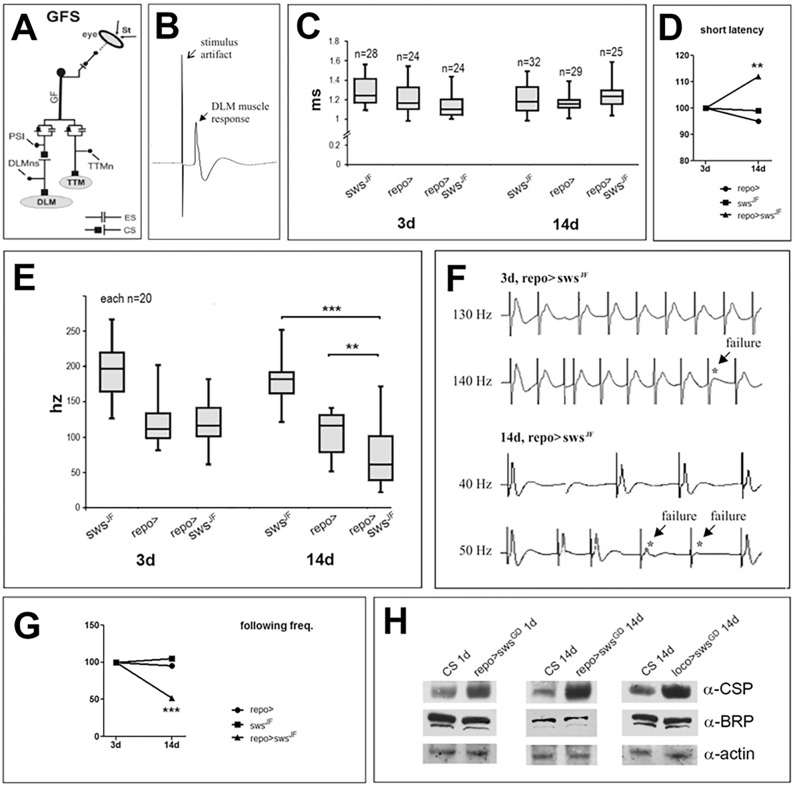
The glial SWS knockdown reduces the reliability of responses in the GF. (A) Schematic of the giant fibre (GF) system (GFS). CS, chemical synapse; ES, electrical synapse; DLM, dorsal longitudinal muscle; DLMns, dorsal longitudinal muscle motor neurons; PSI, peripherally synapsing interneuron; St, stimulus; TTM, tergotrochanteral muscle; TTMn, tergotrochanteral muscle motor neuron. (B) Representative recording of a DLM fibre response to electrical GF stimulation. (C) Quantification of response latencies in controls (repo-GAL4 or swsJF alone) and in glial sws knockdowns (repo-GAL4;swsJF) at 3 and 14 days post-adult-eclosion. The glial knockdown of SWS does not affect response latencies when compared to age-matched controls. (D) A small but statistically significant increase in latency was found in 14-day-old repo-GAL4;swsJF flies compared to 3-day-old ones (Mann–Whitney U-test, **P<0.01), whereas controls showed no age-dependent changes (Kruskal–Wallis ANOVA, P>0.2). (E) Quantification of maximum following frequency. Whereas young repo-GAL4;swsJF flies follow stimulation frequency as reliably as repo-GAL4 controls, they do show lapses in response already at 50 Hz when 14 days old, whereas the controls do not. **P<0.01, ***P<0.001. Boxes demark medians and quartiles, error bars the 10 and 90% values. (F) Representative traces of muscle responses to bouts of ten GF stimuli at different frequencies at 3 (upper traces) and 14 (lower traces) days post-adult-eclosion. Three-day-old glial sws knockdown flies show reliable muscle responses to GF stimulation at 130 Hz and first failures occur at 140 Hz (asterisk). In contrast, the 14-day-old glial sws knockdown already shows failures (asterisks) at 50 Hz GF stimulation. (G) Normalized changes in following frequency with aging for repo-GAL4;swsJF flies, repo-GAL4, and swsJF. A significant decrease with age occurs only in glial SWS knockdown flies. ***P<0.001. (H) Western blots showing that the levels of cystein string protein (CSP) are increased in repo-GAL4;swsGD flies, whereas Bruchpilot (BRP) levels are unaffected. A loading control using anti-actin is shown below.